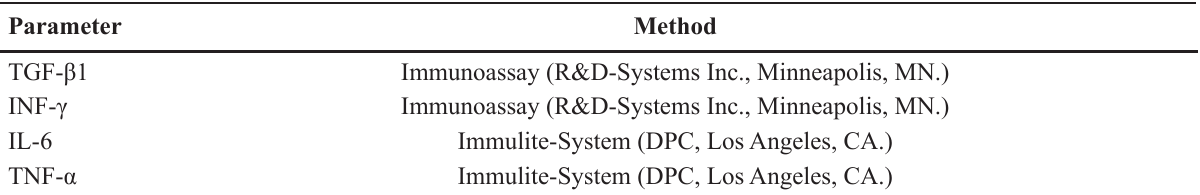
Table 1 – Immunoassays used for cytokine